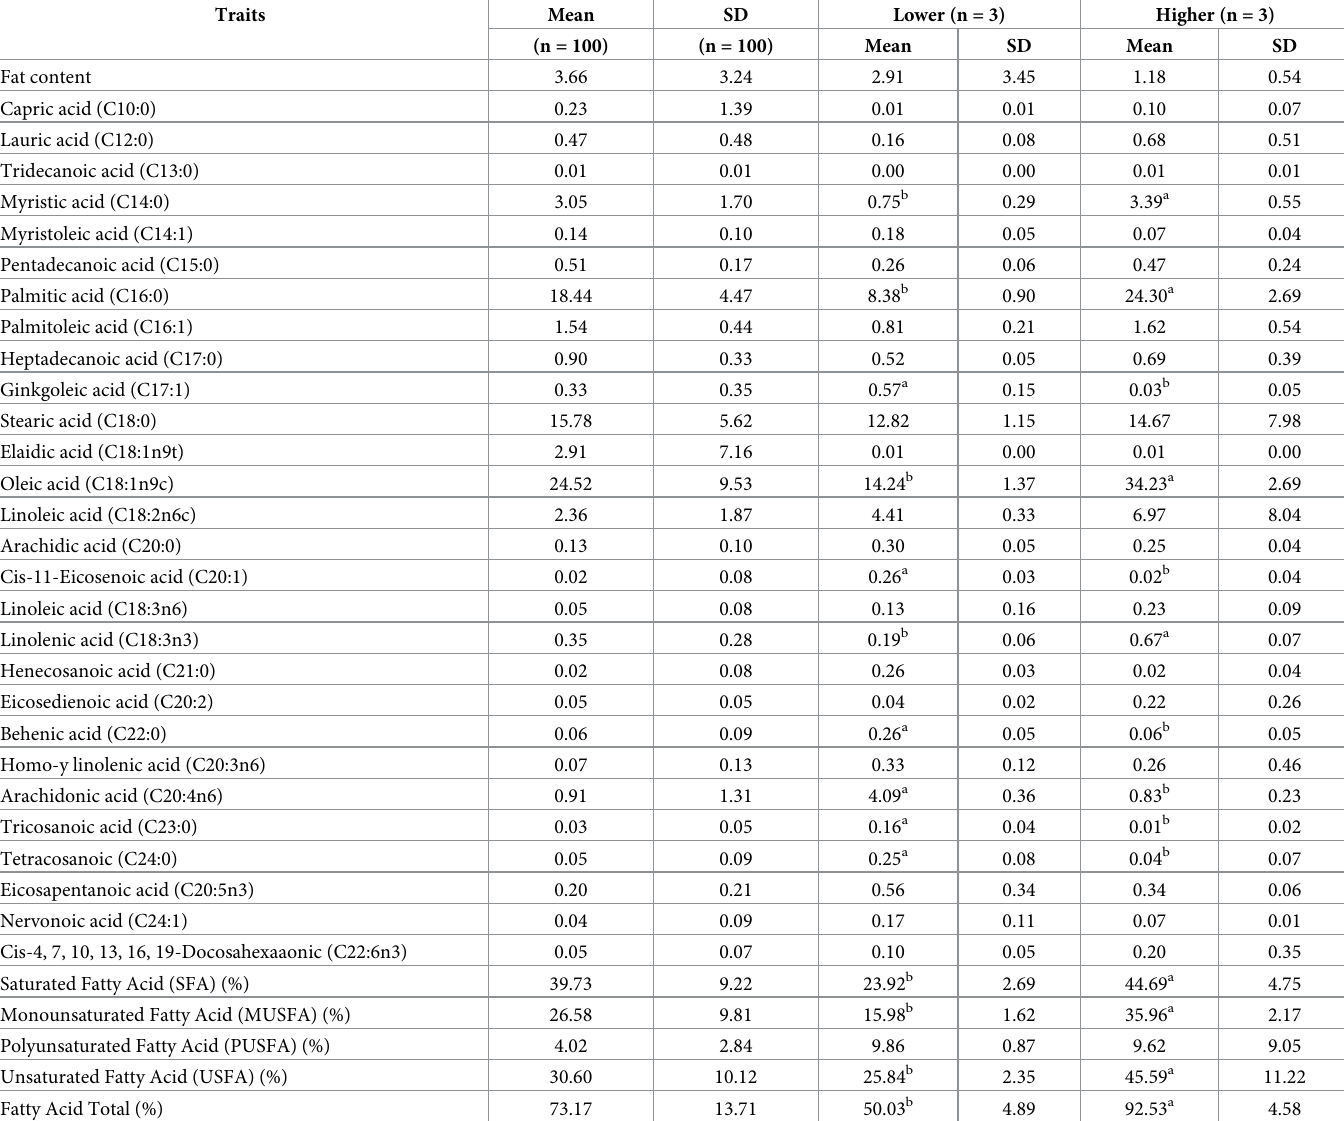
Mean ± SD are units of percentage fatty acid composition. ab Mean value with different superscript letters in the same row differ significantly at P <